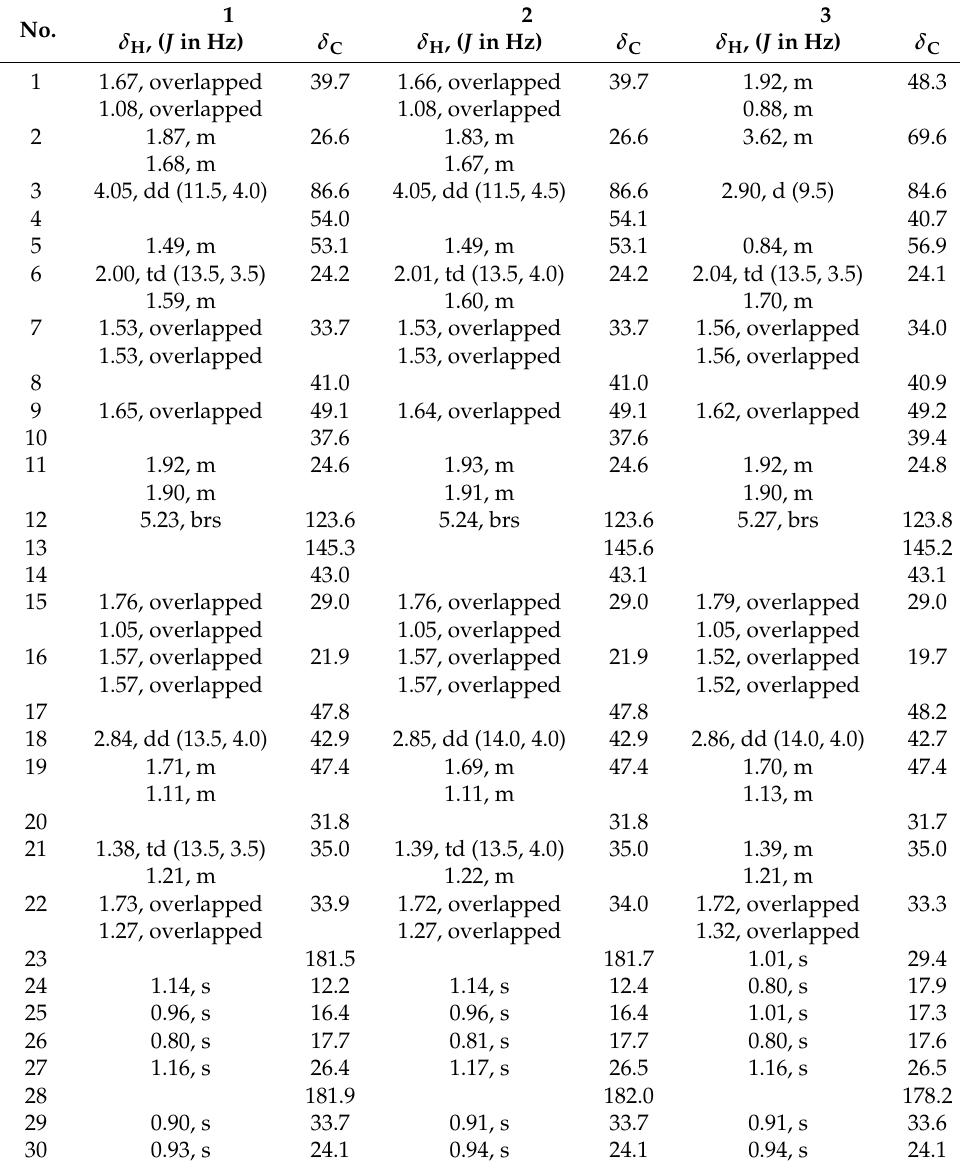
Table 1. 1 H NMR (500 MHz) and 13 C NMR (125 MHz) data of compounds 1 – 3 in methanol- d 4 .